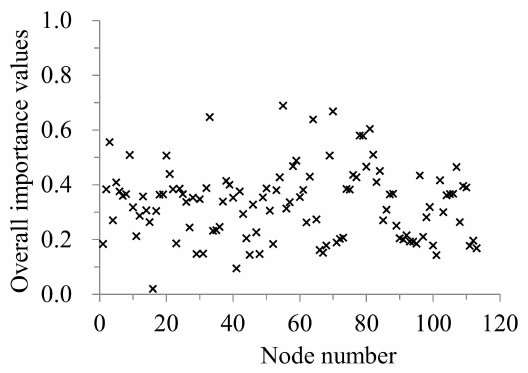
Figure 12. Overall importance values of